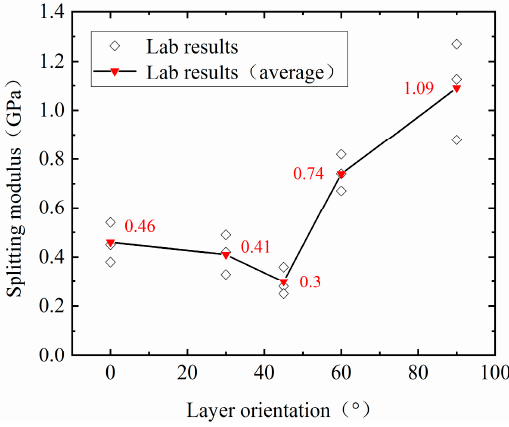
Figure 8. Layer orientation effect coefficient.